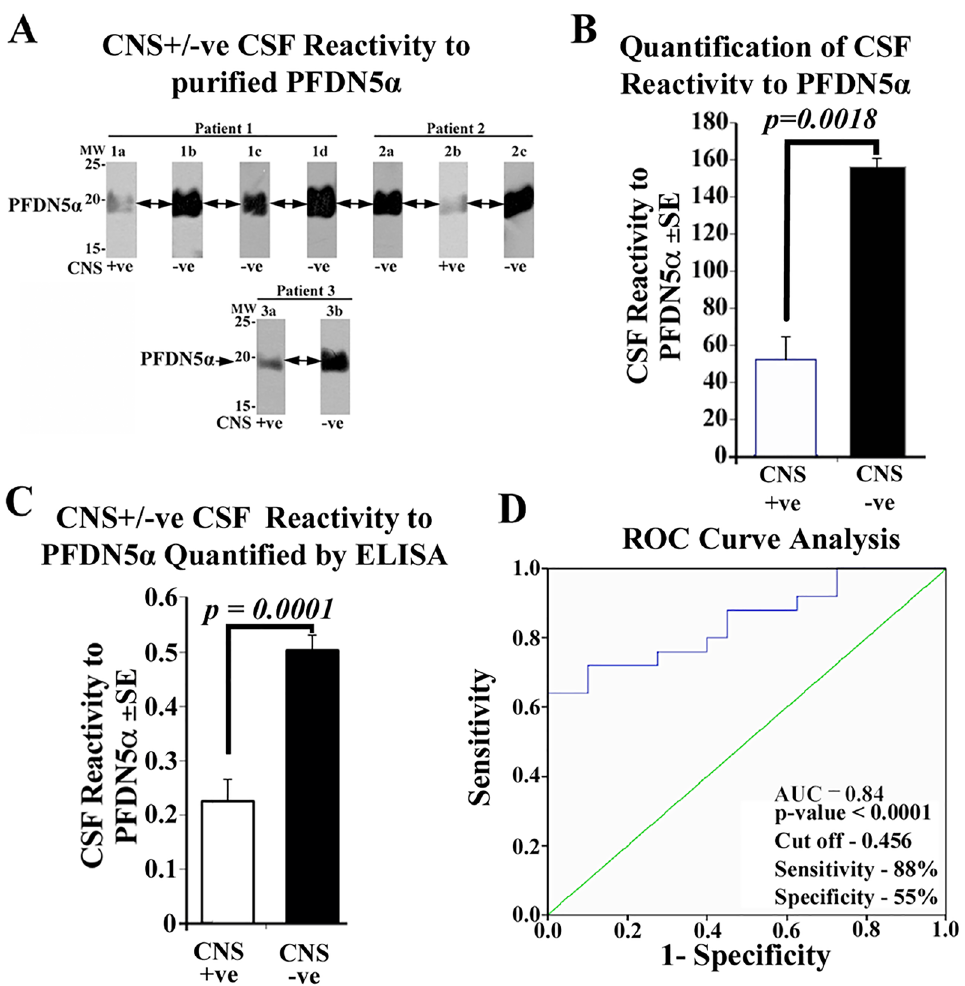
Figure 2. Validation analysis and quantification of CSF reactivity to purified recombinant PFDN5α using 1D western and ELISA platforms for determination of cut-off value by ROC curve analysis for prognostication. ( A ) Western blots showing validation of differential CSF reactivity of CNS +ve (presentation/relapse) and CNS −ve (remission) sequential samples from patients 1, 2 and 3 towards purified recombinant PFDN5α. The pattern of CSF reactivity validates to that observed on the 2D far western blot (Fig. 1A). ( B ) Quantification of CNS +ve [51.25 ± 23.23; n = 3; from 1a, 2b and 3a) and −ve (156.3 ± 8.27; n = 3; from 1d, 2c and 3b) CSF reactivity to purified PFDN5α protein showing statistical significance (* p = 0.0018; CNS +ve vs −ve). ( C ) Further validation and quantification of CSF reactivity of CNS +ve (n = 25) and −ve (n = 40) CSF samples to purified PFDN5α by ELISA showed statistically significant difference between CNS +ve (0.225 ± 0.202) and −ve (0.502 ± 0.177) CSF samples ( p = 0.0001). ( D ) Receiver operating characteristic (ROC) curve analysis of reactivity to PFDN5α towards CNS +ve and −ve CSF samples to identify cut-off value to predict the CNS positivity in patients. The ROC curve plot shows that the area under the curve is 0.84 (95% CI 0.74–0.95; p = 0.0001) and the cut-off value at 88% sensitivity and 55.0% specificity is